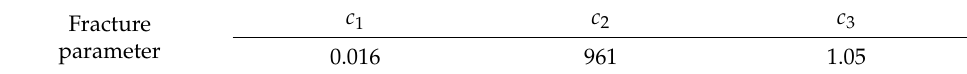
Table 4. Fracture parameters of the modified Mohr–Coulomb fracture model for 304L stainless steel sheet.